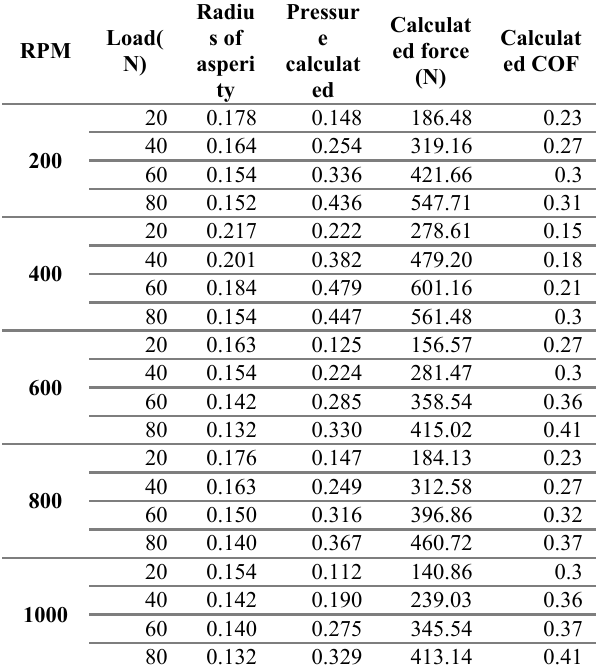
Figure 11. 2D Profile image for (a) 200 Rpm, (b) 400 Rpm, (c) 600 Rpm, (d) 800 Rpm and (e) 1000 Rpm and Optical profilometry images showing three- dimensional (3D) surface morphologies of (a’) 200 Rpm, (b’) 400 Rpm, (c’) 600 Rpm, (d’) 800 Rpm and Table 3. Estimation of